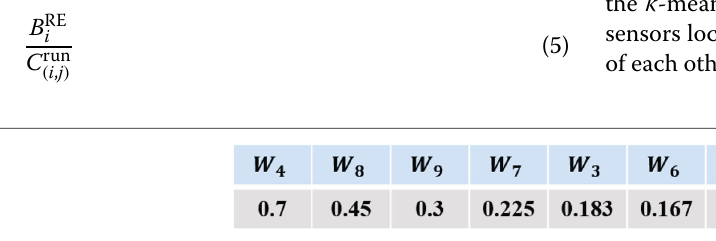
in this round, we can choose a sensor to be ignored in this cycle such that the resultant charging tour is short or the mobile charger can recharge more sensors. Therefore, when the mobile charger can not recharge a sensor, we will use Eq. (5) to select a sensor to ignore in this cycle, where C run ( is the energy consumption of the mobile charger in i , j ) is the amount of energy the moving from s i to s j and B RE i mobile charger uses to recharge s i . This idea is similar to a greedy rule that wants to find a short charging tour in the yellow group but the sensors with higher weights can also have a high priority to be included in the charg- ing tour. Figure 9 is an illustration of the charging tour planning of the sensors in the yellow group. Suppose the order of the weights of the sensors in the yellow group is w 8 > w 9 > w 7 > w 3 > w 6 > w 1 > w 2 . Firstly,